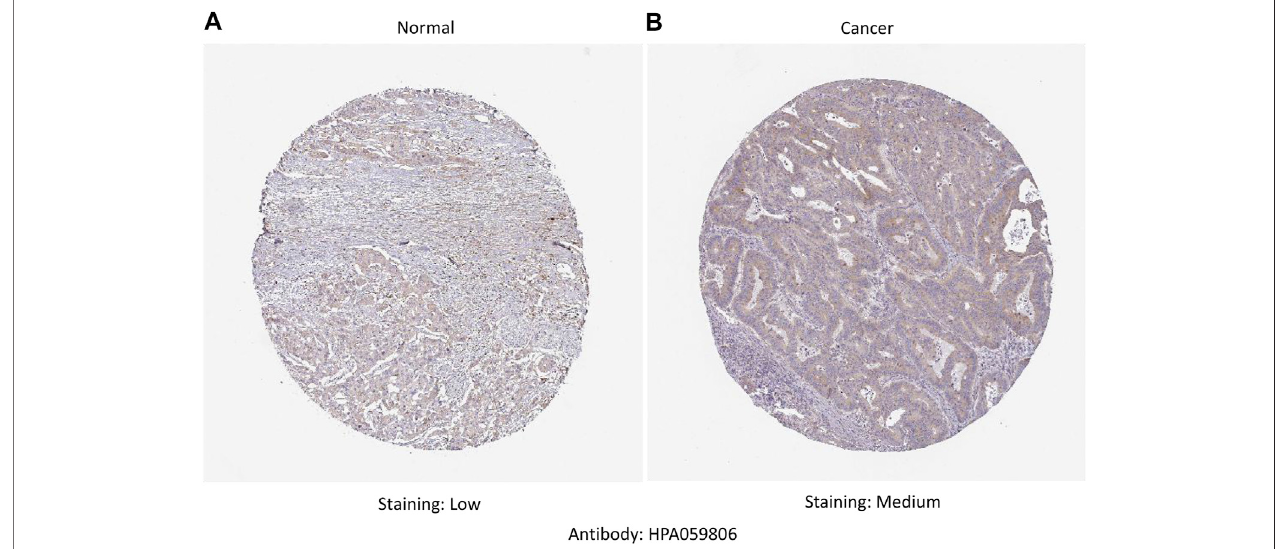
FIGURE 3 | Analysis of CTHRC1 expression in patients with colon adenocarcinoma (COAD) under different physiological or pathological states using UALCAN. (A – F) CTHRC1 expression in COAD patients of various physiological and pathological states (* denotes 0.01 < p < 0.05, ** denotes p < 0.01).